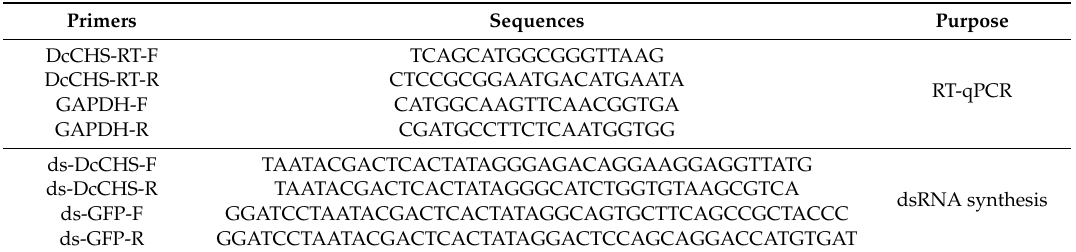
Table 1. Primers used in this